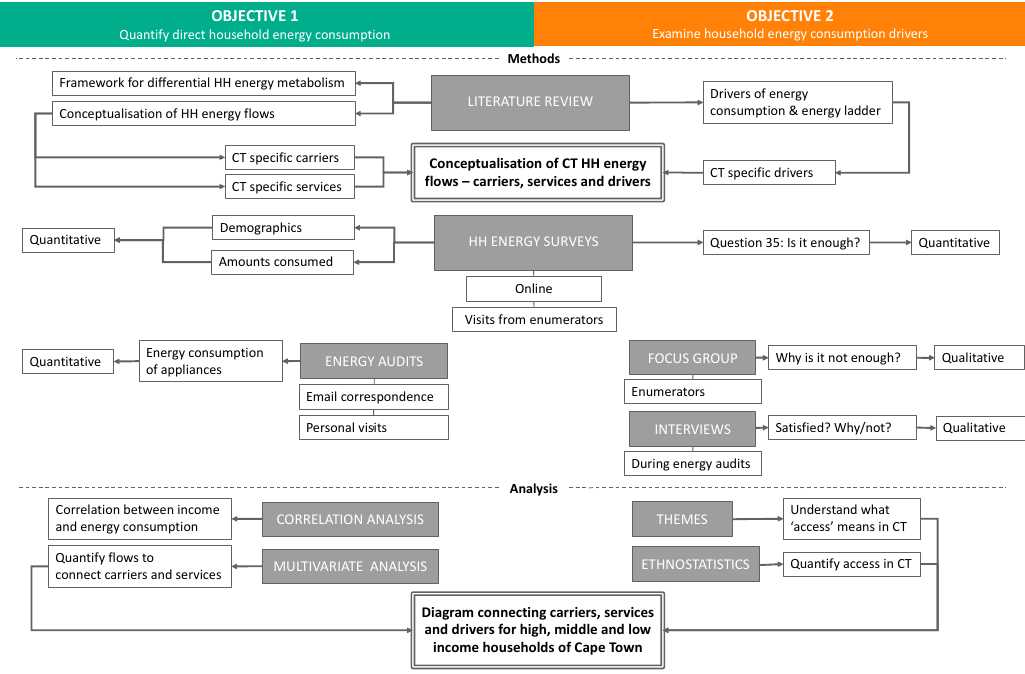
Figure 3. Method conceptualization. Note: CT is Cape Town; HH is household .